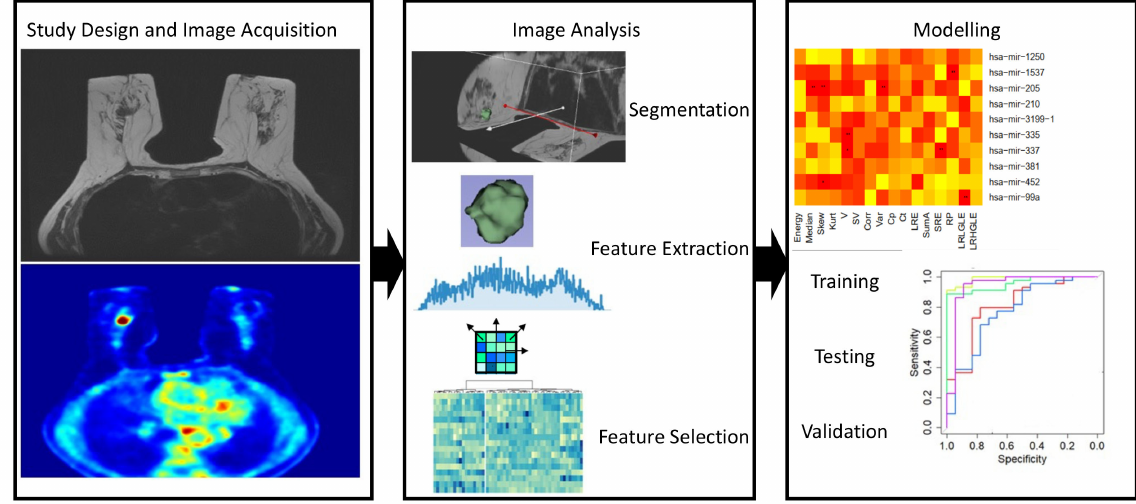
Figure 1. The radiomic